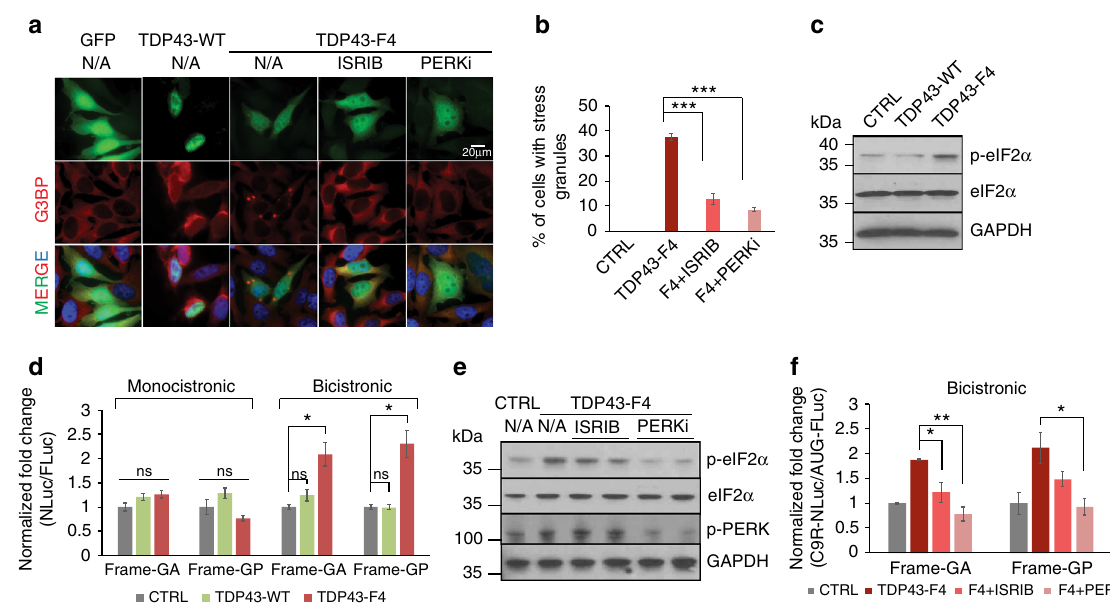
Fig. 4 TDP-43 prion-like domain promotes RAN translation through phospho-eIF2 α . a GFP fl uorescence and G3BP immuno fl uorescence of HeLa Flp-In cells transfected with GFP control, TDP43-WT, or TDP43-F4, without or with the treatment of ISRIB or PERKi. b Quanti fi cation of stress granule numbers per GFP-positive cell in a . More than 100 cells were counted in each condition. *** P < 0.0001, two-tailed t- test. c Immunoblotting using antibody recognizing phospho-eIF2 α showed its upregulation with TDP43-F4 expression, compared to GFP and TDP43-WT controls. GAPDH and total eIF2 α were blotted as internal control. d After 1 day of transfection cells were induced to express translation reporters by doxycycline, and luciferase activities were measured after another 24 h. NLuc signals were normalized to FLuc in each sample and the relative expression was compared to GFP transfection control. * P < 0.05, two-tailed t- test. e Cells were treated with ISRIB or PERKi after transfection with TDP43-F4. Immunoblotting with antibodies recognizing phospho-eIF2 α , eIF2 α , phospho-PERK, and GAPDH. f Fold change of bicistronic RAN translation reporter expression upon TDP43-F4 expression, without or with the treatment of ISRIB or PERKi. * P < 0.05, ** P < 0.005, two-tailed t- test. Data are mean ± SEM from three biological